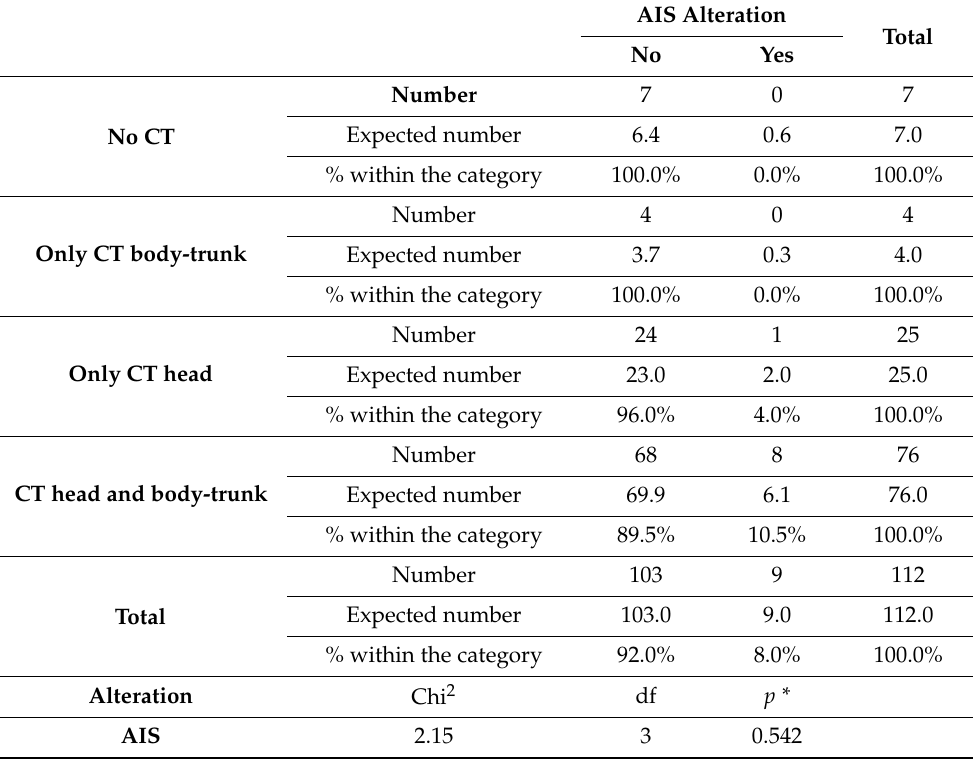
Table 8. Correlation between received diagnostic computed tomography (CT) and AIS change.